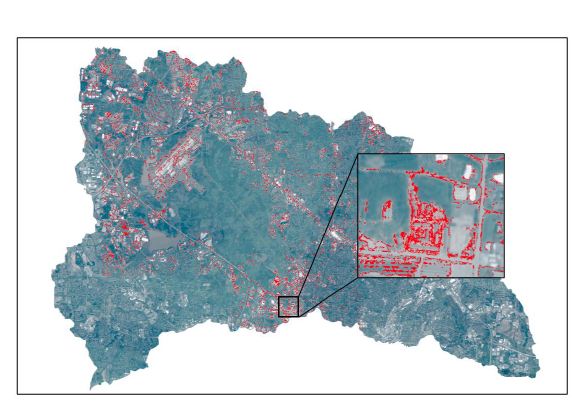
Figure 8: Results from post classification pixel class change comparison between February and April 2019. Red indicates a change from a class to road, building or barren (impervious sur-